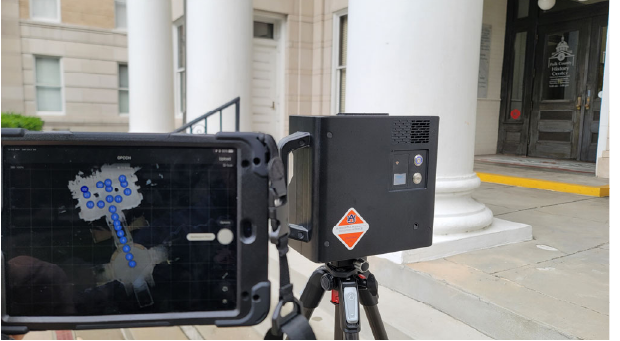
Figure 22. Capturing aerial photos of the OPCC with an UAV: ( a ) a DJI Mavic Pro2 UAV taking off to capture aerial photos; ( b ) the pre ‐ programmed UAV flight routes.